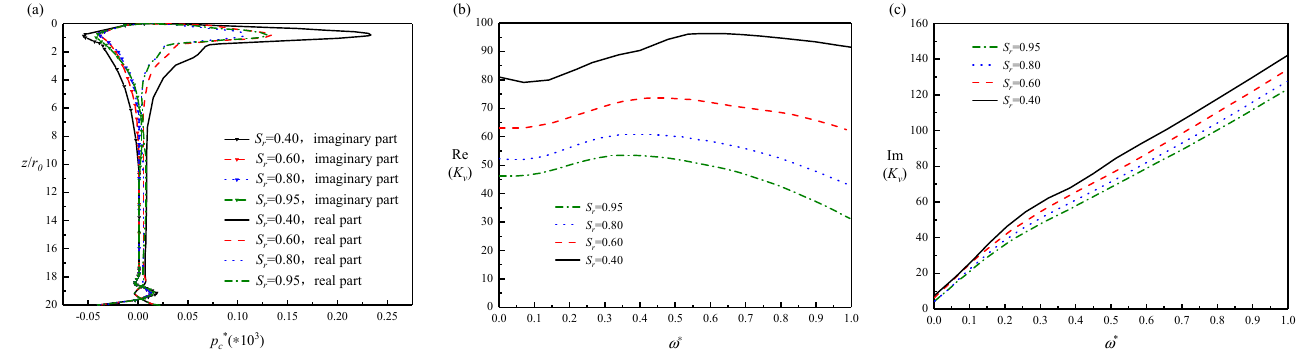
Figure 5. Influence of saturation of unsaturated soil: ( a ) matric suction; ( b ) dynamic longitudinal stiffness; ( c ) dynamic longitudinal damping (reproduced from Ye and Ai (2022) [43]).